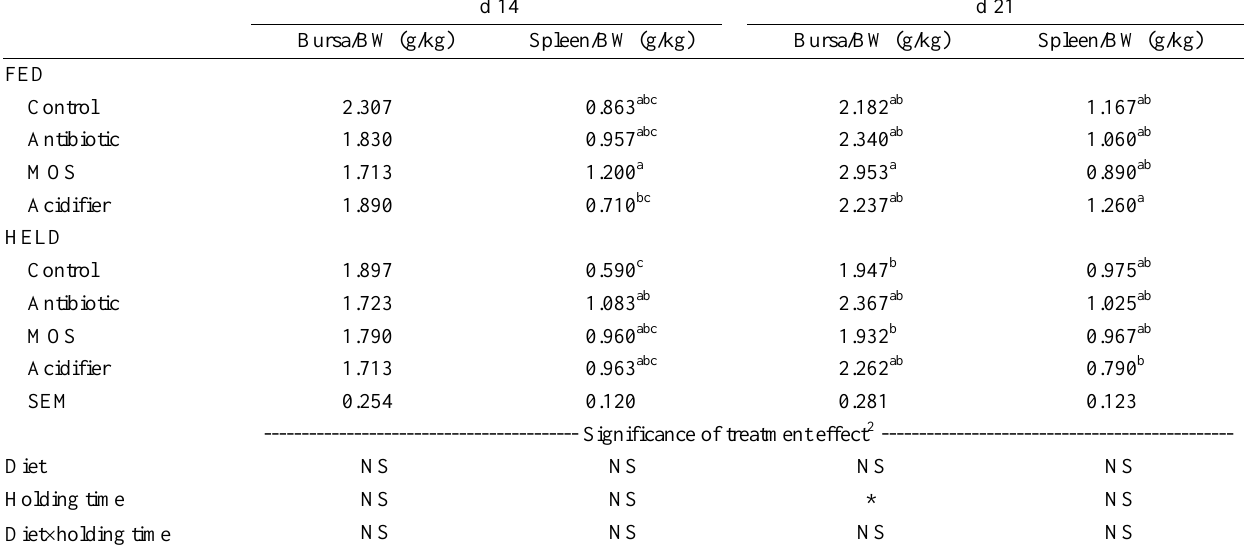
Table 5. Effects of post hatch holding time and dietary supplements on lymphoid organ weights as a percentage of body weight at d 14